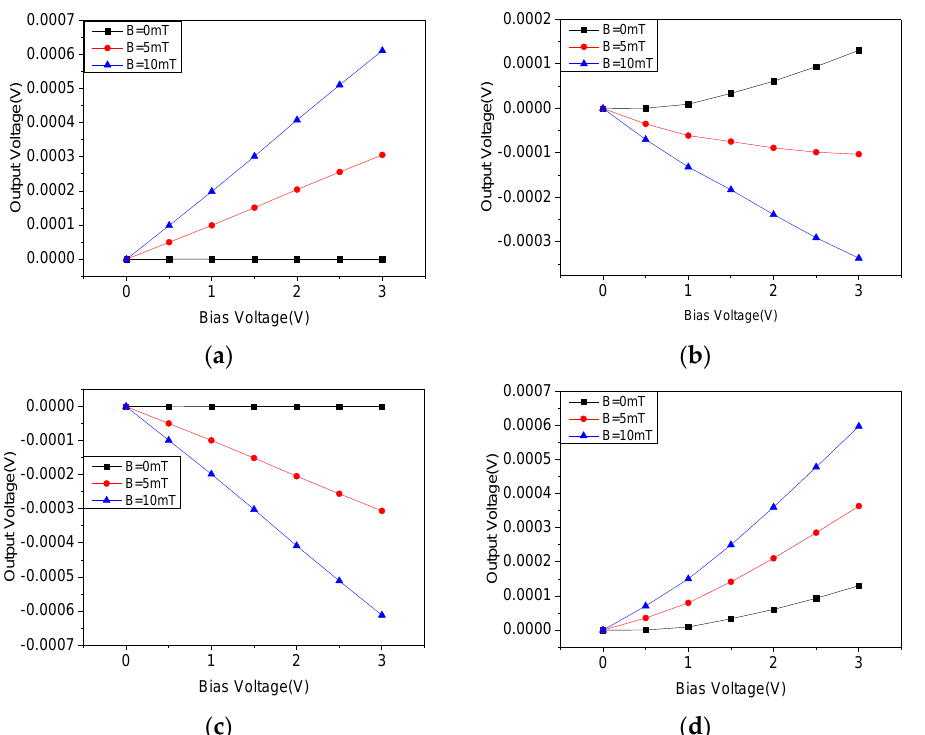
Figure 9. The output voltages between the Hall electrodes of the double three-contact structure. ( a ) Phase 0; ( b ) Phase 90; ( c ) Phase 180; ( d ) Phase 270.